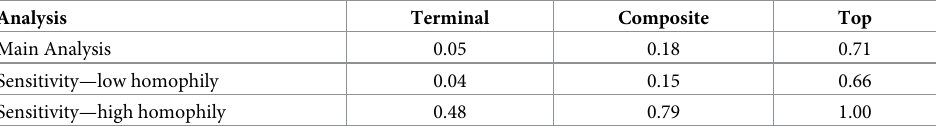
Table 3. Sensitivity analysis. Impact of missing gender indicators. For each strategy, we show the average proportion (across the 10 imputations) of terminal, composite, and top-level fields exhibiting statistically significant behavioral homophily using the Benjamini-Yekutieli FDR control with